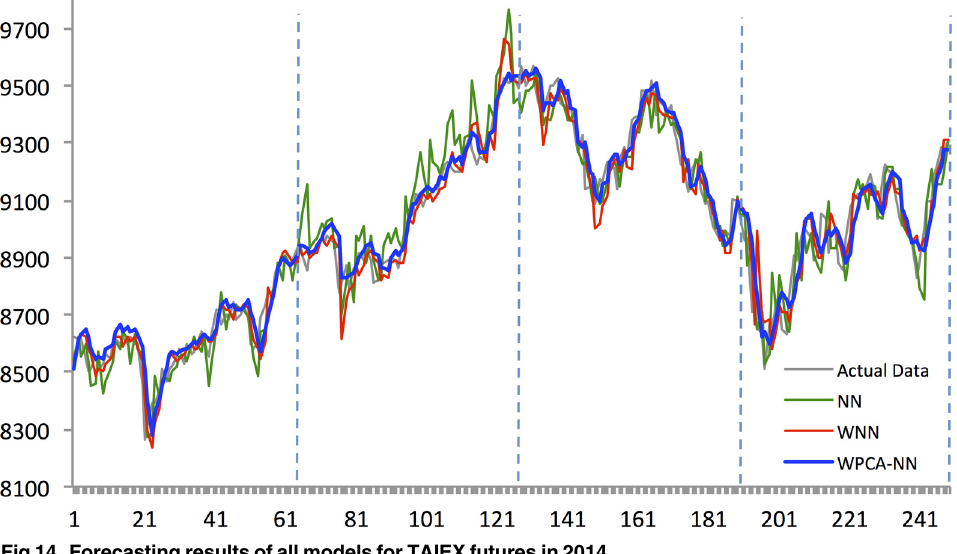
Fig 14. Forecasting results of all models for TAIEX futures in